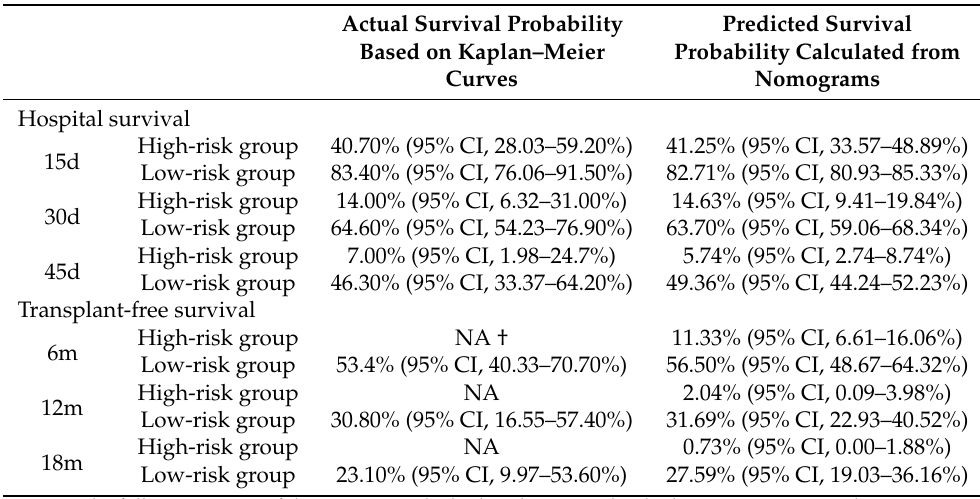
Figure 4. Kaplan–Meier curves of hospital survival ( A ) and transplant-free survival ( B ) according to low-risk or high-risk groups stratified by nomogram predictions. The p values were calculated using the log-rank test. Table 3. Comparison between actual survival probability and predicted survival probability.